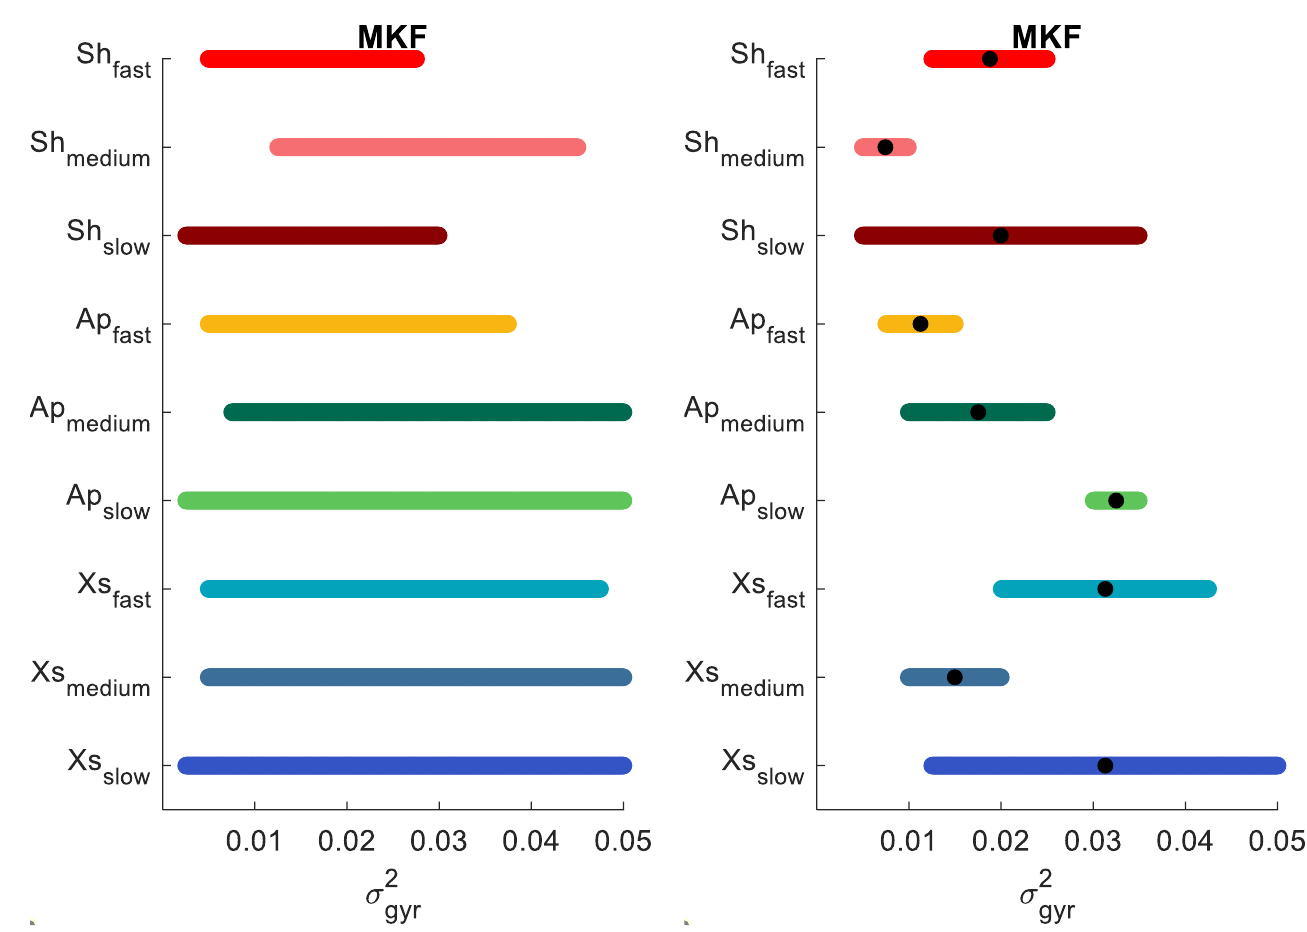
Figure A1. This appendix provides the optimal and the suboptimal regions for each SFA. Mono-dimensional intervals were represented instead of two-dimensional regions for those SFAs with only one parameter value tuned (MAD; MCF, GUO, MKF).